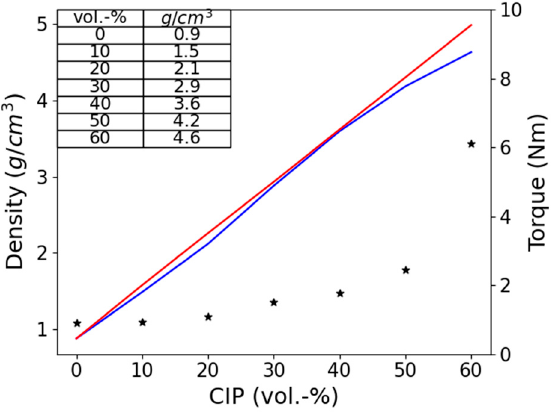
Figure 6. The torque at the end of the mixing process and density of the SEBS-based composite in relation to the volume concentration of CIP. The red line shows the calculated density based on the mixing rule. The blue line presents the measured density, and the stars are torque measured in Nm.